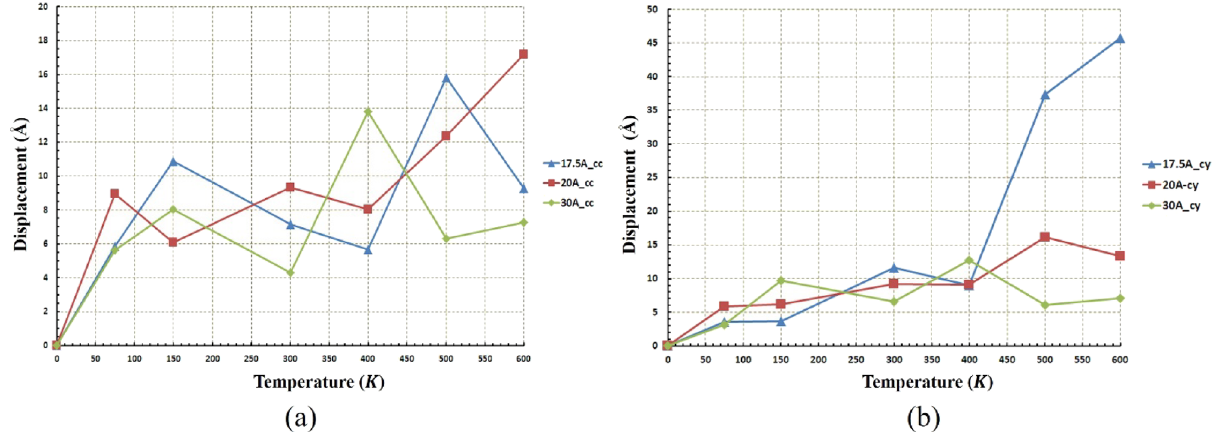
Figure 17. Displacement of the nanotruck at different temperatures and radii ( a ) for the concave (cc) substrates and ( b ) for the cylindrical (cy) substrates. Due to fluctuating movement of nanotruck in almost all conditions, the average displacement in both geometries is the same. The maximum displacement of nanotruck has occurred in the radius of 17.5 Å cylindrical substrates at 600 K